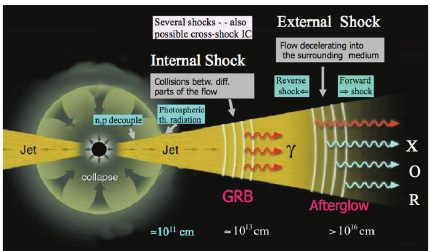
Figure 13: Cartoon showing the basic ingredients of the GRB “fireball” model. (1) The source of energy is a collapse of a massive star (or merger of NS-NS or NS-BH, not shown here). (2) Part of this energy is used in producing the relativistic jet. This could be mediated by hot photons (“fireball”), or by magnetic field. (3) The thermal photons decouple at the photosphere. (4) Part of the jet kinetic energy is dissipated (by internal collisions, in this picture) to produce the observed 𝛾 rays. (5) The remaining kinetic energy is deposited into the surrounding medium, heating it and producing the observed afterglow. Cartoon is taken from Meszaros and Rees